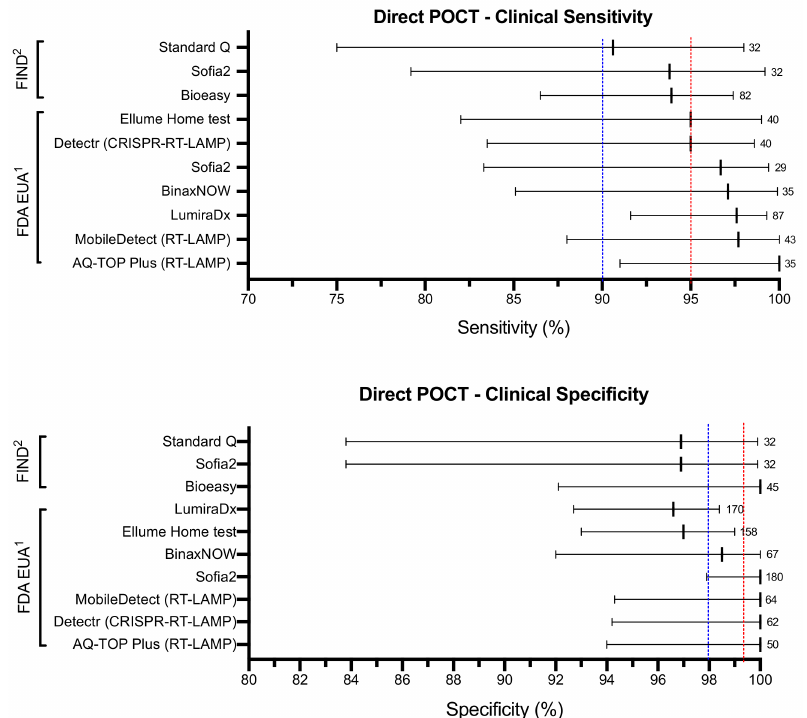
Figure 2. Clinical sensitivity and specificity of direct POCTs. Selected POCTs that met WHO TPP (direct detection of SARS-CoV-2) “desirable” clinical sensitivity criteria. Short vertical lines represent the calculated clinical sensitivity (top panel) and clinical specificity (bottom panel) values. Horizontal bars represent lower and upper 95% confidence intervals. Blue and red lines represent WHO TPP “acceptable” and “desirable” thresholds, respectively. Numbers represent total positive (sensitivity) and negative (specificity) clinical samples tested. All reported values were obtained from FDA, FIND, or manufacturer’s instruction for use (IFU) and have not been validated by our group. 1 Performance data based on manufacturer’s claims reported in FDA EUA database. 2 Performance data based on independent evaluation tests reported in FIND database.